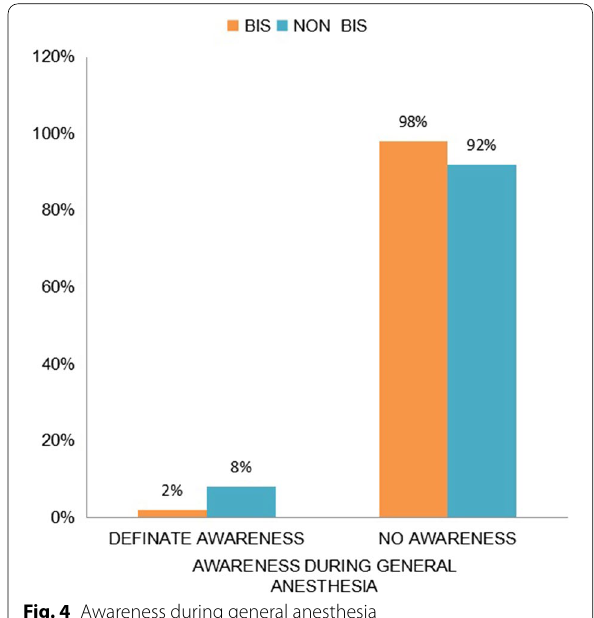
Fig. 4 Awareness during general